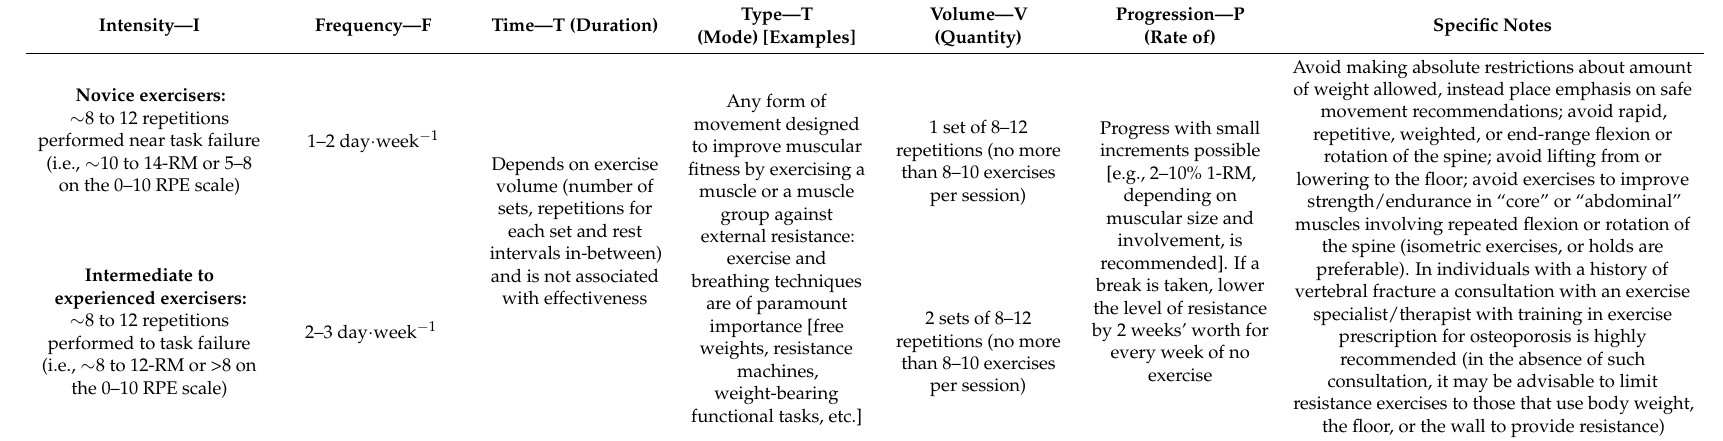
Table 2. Resistance (strength) exercise recommendations for ageing postmenopausal